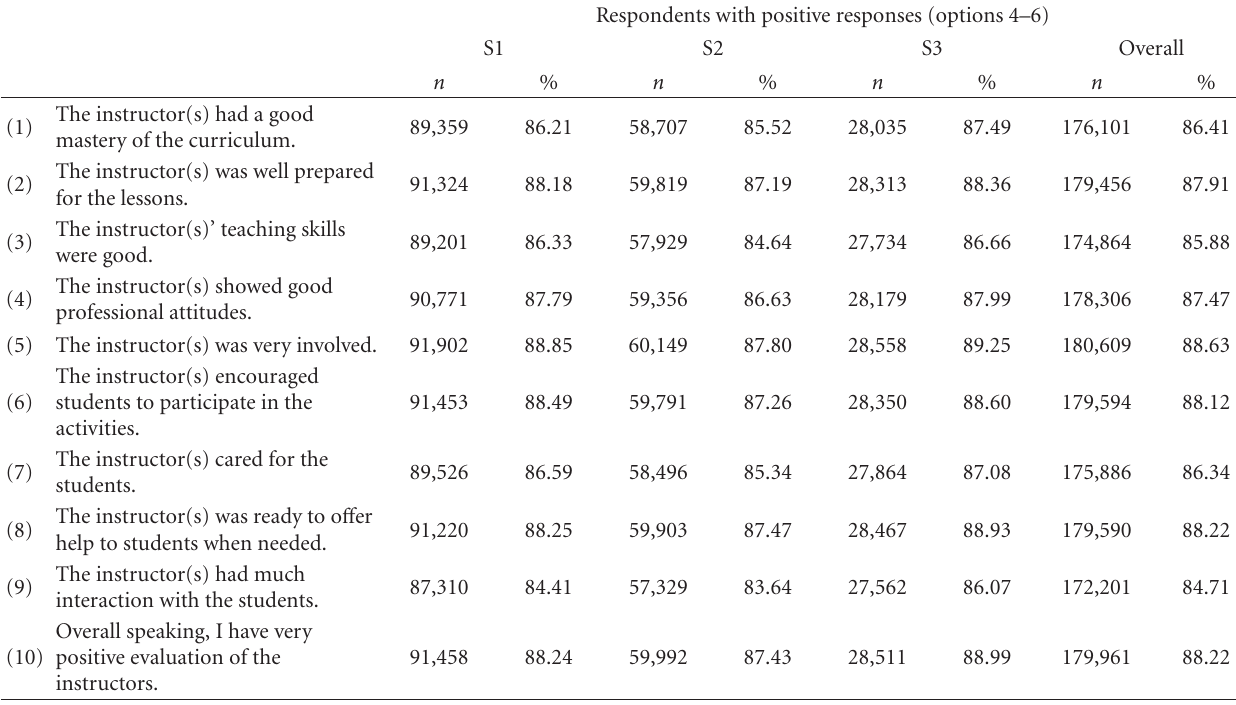
Table 3: Summary of the students’ perception towards the performance of program